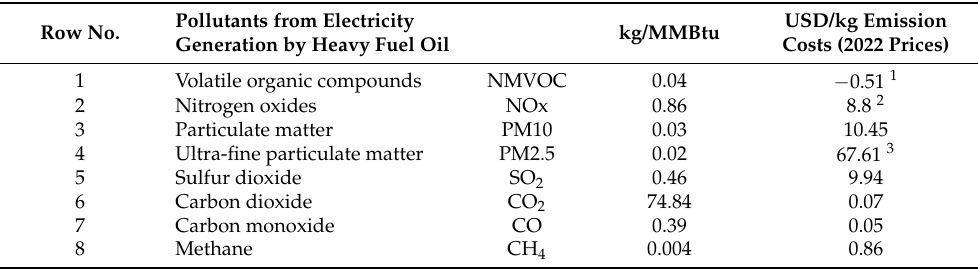
Table 9. The environmental emission costs and economic costs of the pollutants of the diesel fuel